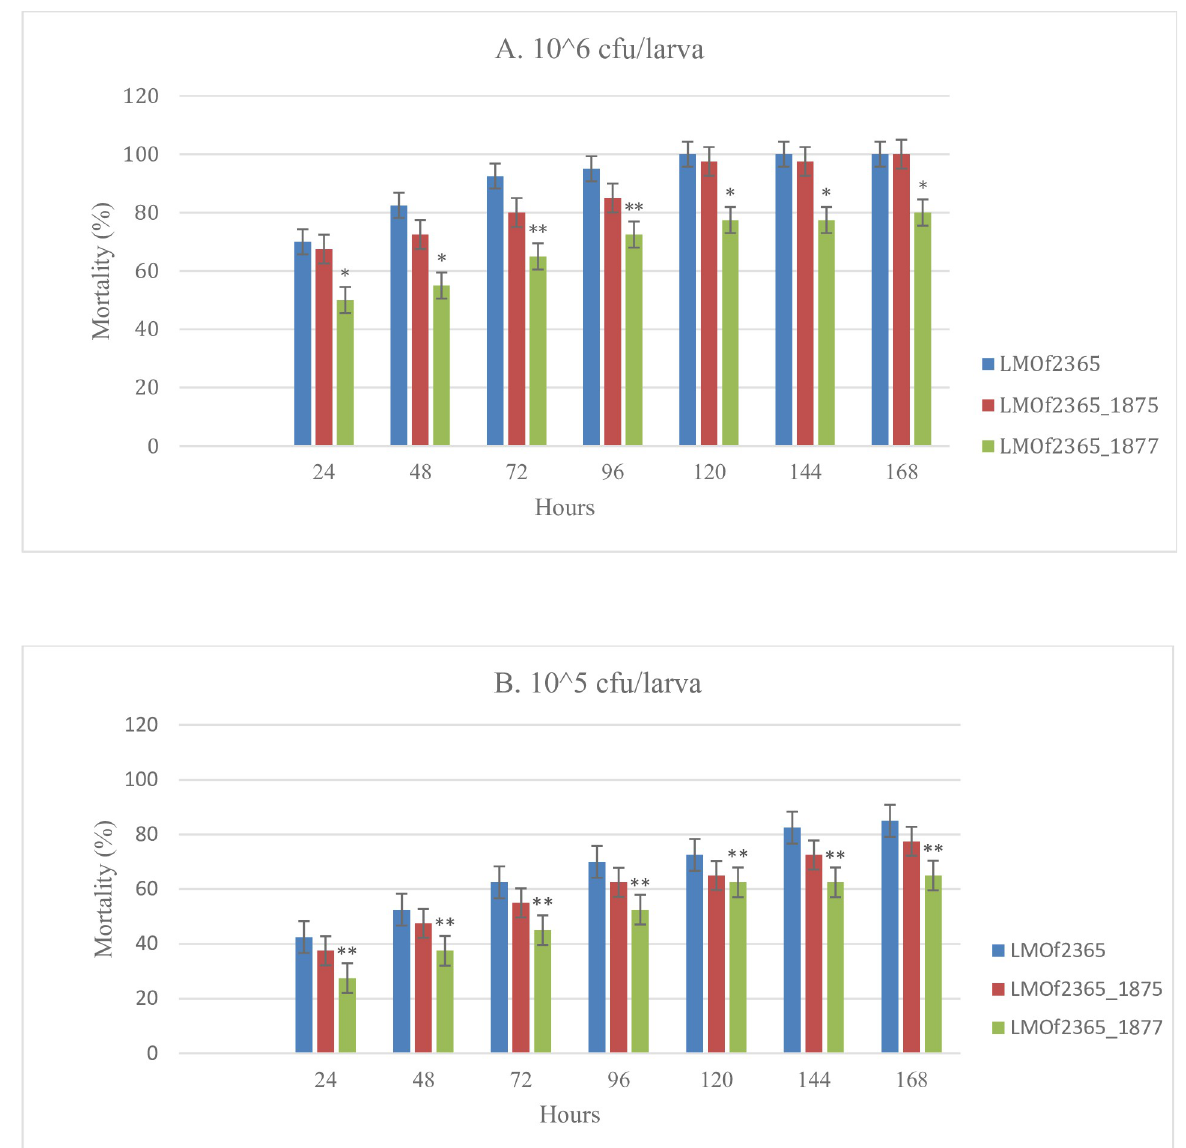
Fig 3. Comparison of mortality rates of deletion mutants ⊿ LMOf2365_1875 and ⊿ LMOf2365_1875 with wild type LMOf2365 in G . mellonella using 10 6 CFU/larva (A) and 10 5 CFU/larva (B). � Significant difference from both parental strain and Δ LMO2365_ 1875. �� Significant difference from parental strain. Data presented are the averages of three independent